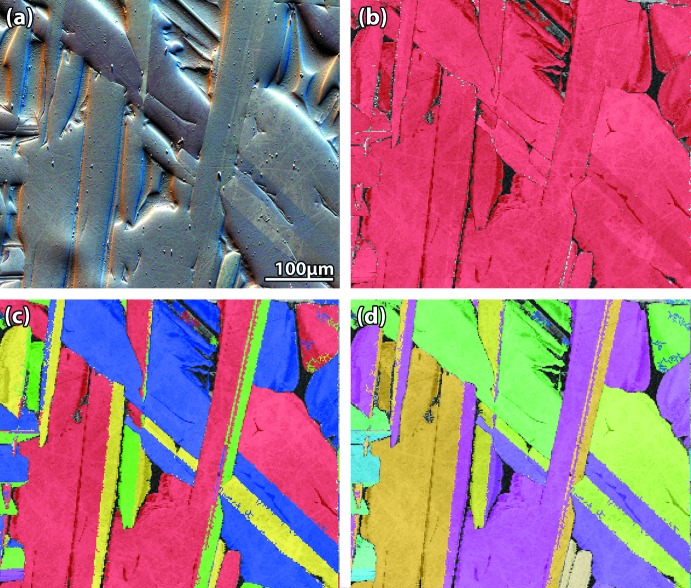
EBSD pattern collage including the (a) Argus image, (b) phase map refined using the crystallographic information file (CIF), (c) grain map, and (d) inverse pole figure (in the X-direction) map.